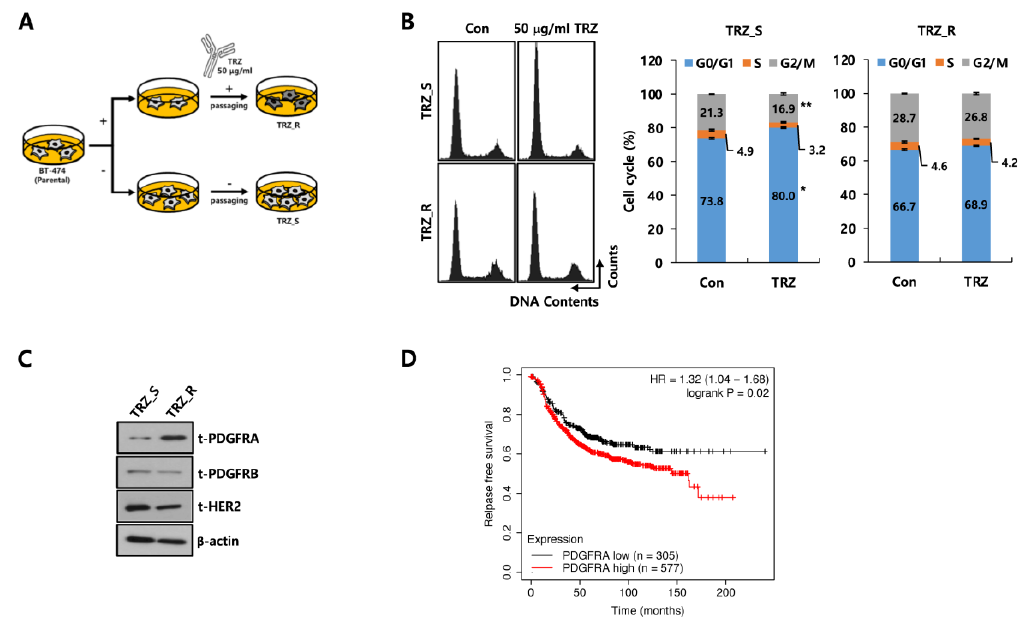
Figure 1. The high expression of the platelet-derived growth factor receptor alpha (PDGFRA) predicts the poor survival of patients with HER2-positive (HER2+) breast cancer. ( A ) A schematic model showing the generation of the trastuzumab-resistant (TRZ_R) cell line. BT474 TRZ_R cells were established by culturing wild type BT474 breast cancer cells in the presence of 50 µ g/mL TRZ for around 6 months. ( B ) BT474 trastuzumab-sensitive (TRZ_S) and TRZ_R cells were treated with or without 50 µ g/mL TRZ for 48 h. Then, the cell cycle was analyzed. Each experiment was carried out three independent times. Data are presented as the mean ± SEM (* p < 0.05, ** p < 0.01). ( C ) PDGFRA, PDGFR beta (PDGFRB), HER2, and β -actin levels were analyzed by Western blotting. ( D ) Relapse-free survival (RFS) of the HER2+ breast cancer patients with high (n = 577) or low (n = 305) PDGFRA expression were analyzed using the Kaplan–Meier plotter database. The patients were split by using the Auto select best cutoff